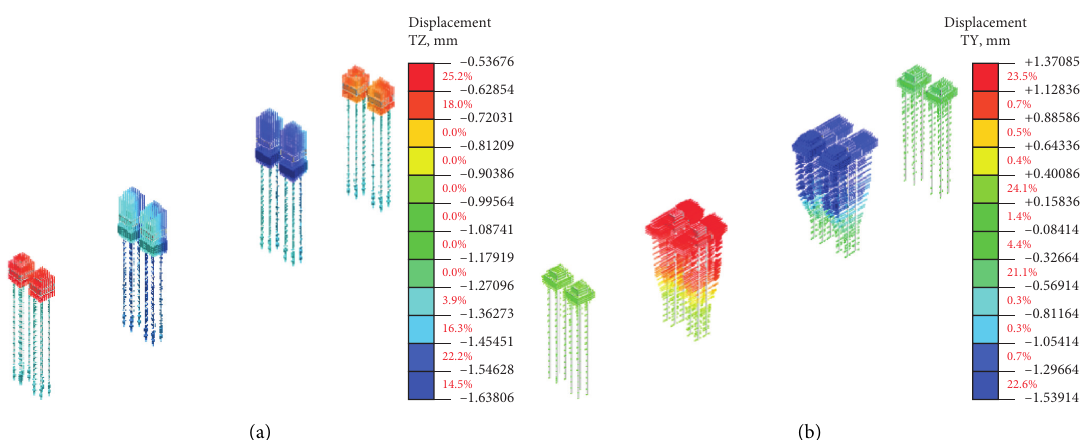
Figure 17: Displacement diagram of pile foundation after grouting reinforcement. (a) Settlement diagram. (b) Horizontal displacement